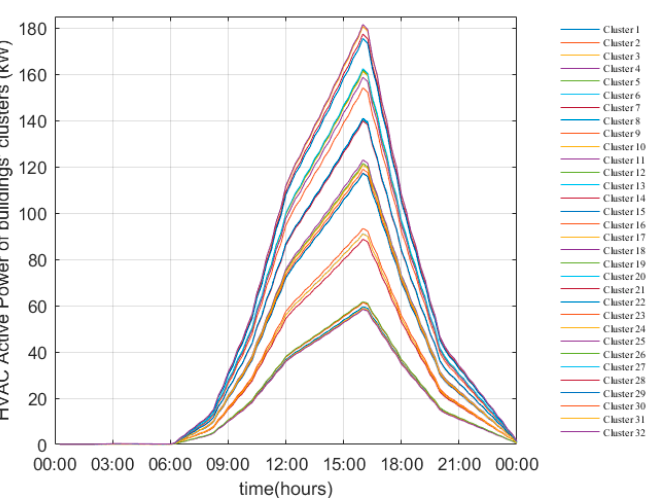
Figure 11. Building clusters’ HVAC power consumption in each distribution network node.